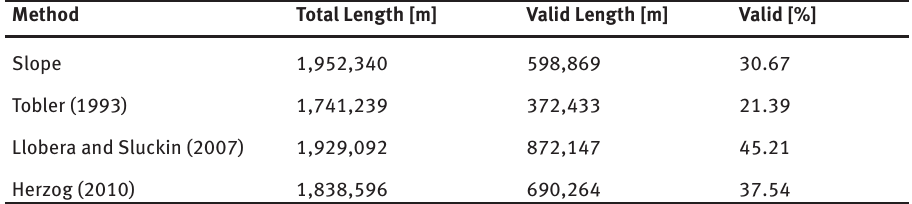
Table 2: Validation of the LCP methods using OSM reference data. The total length of all reconstructed routes is shown in the second column. The third column shows the sum of the reconstructed routes that are comparable to OSM data. The ratio of both is shown in the last